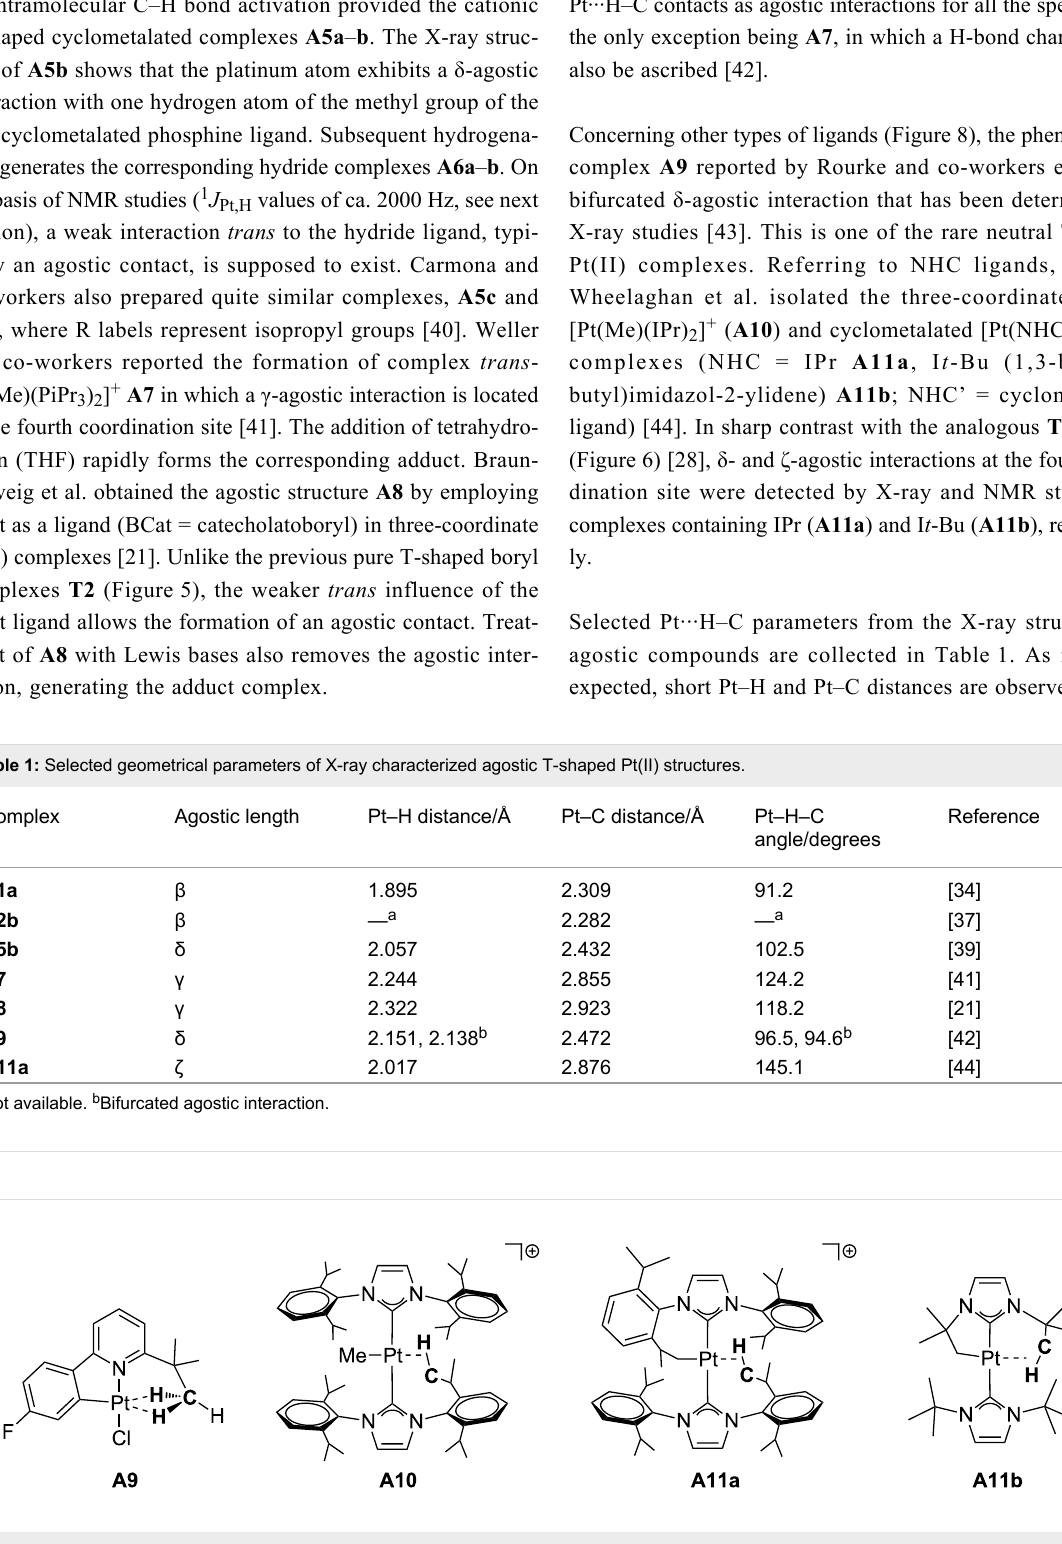
Figure 8: Phenylpyridine and NHC-based agostic T-shaped Pt(II)